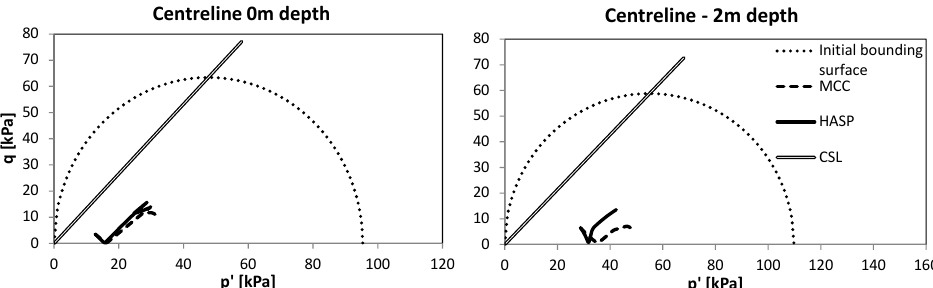
Figure 16. Effective stress paths for HASP and MCC models for center line at 0 and 2 m depth for Embankment B.